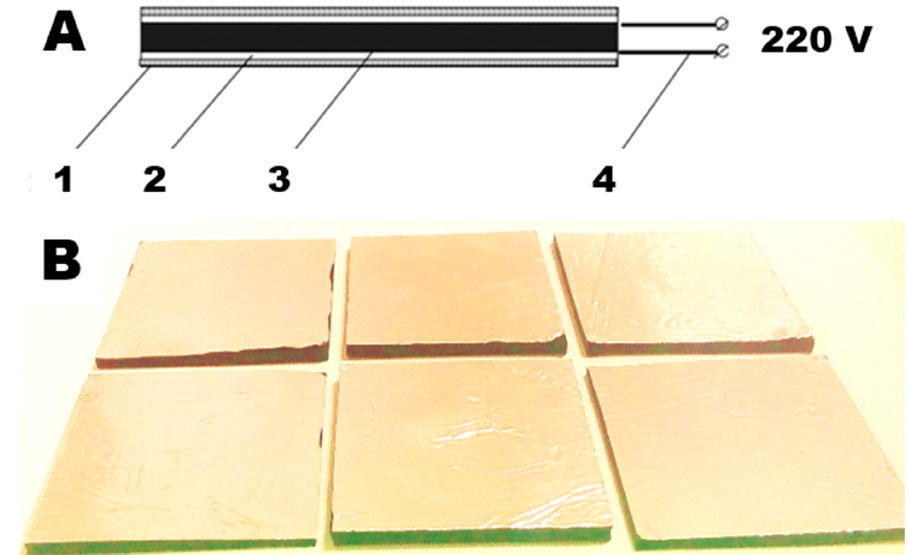
Figure 1. ( A ) Schematic diagram of a self-regulating constant current heater: 1—dielectric shell; 2—current collectors; 3—functional material of the heater; 4—connectors. ( B ) Heaters used in the current study.